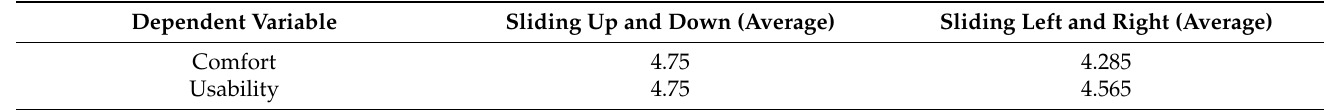
Table 6. Comfort and usability analysis of different sliding modes.